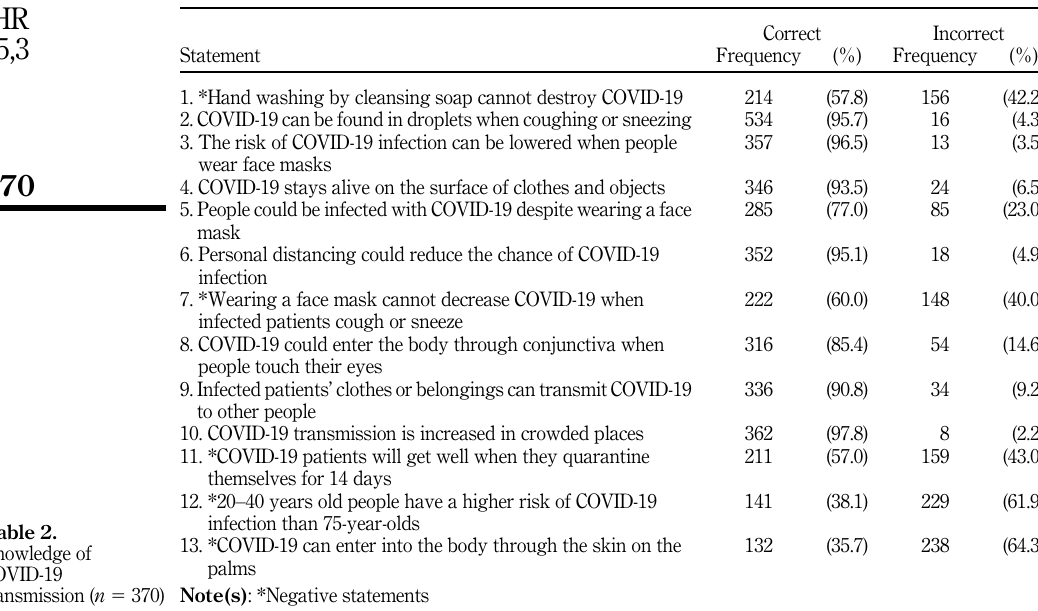
COVID-19 transmission ( n 5